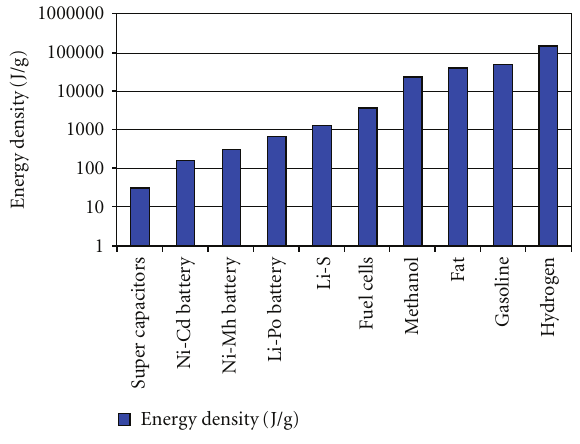
Figure 19: Energy densities of various energy storage systems, graph adapted from [33, 53, 75–77].